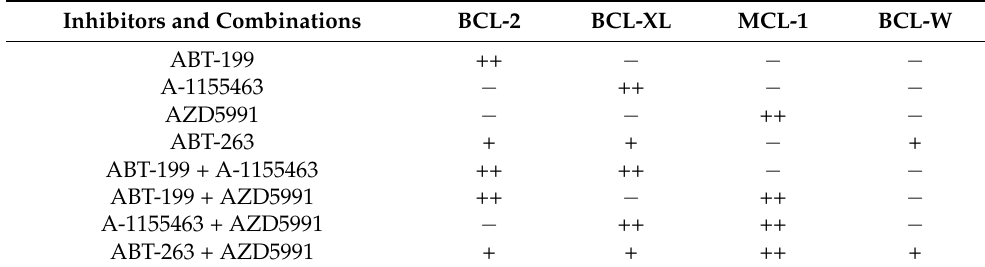
Table 1. Overview of the targets of the inhibitors and